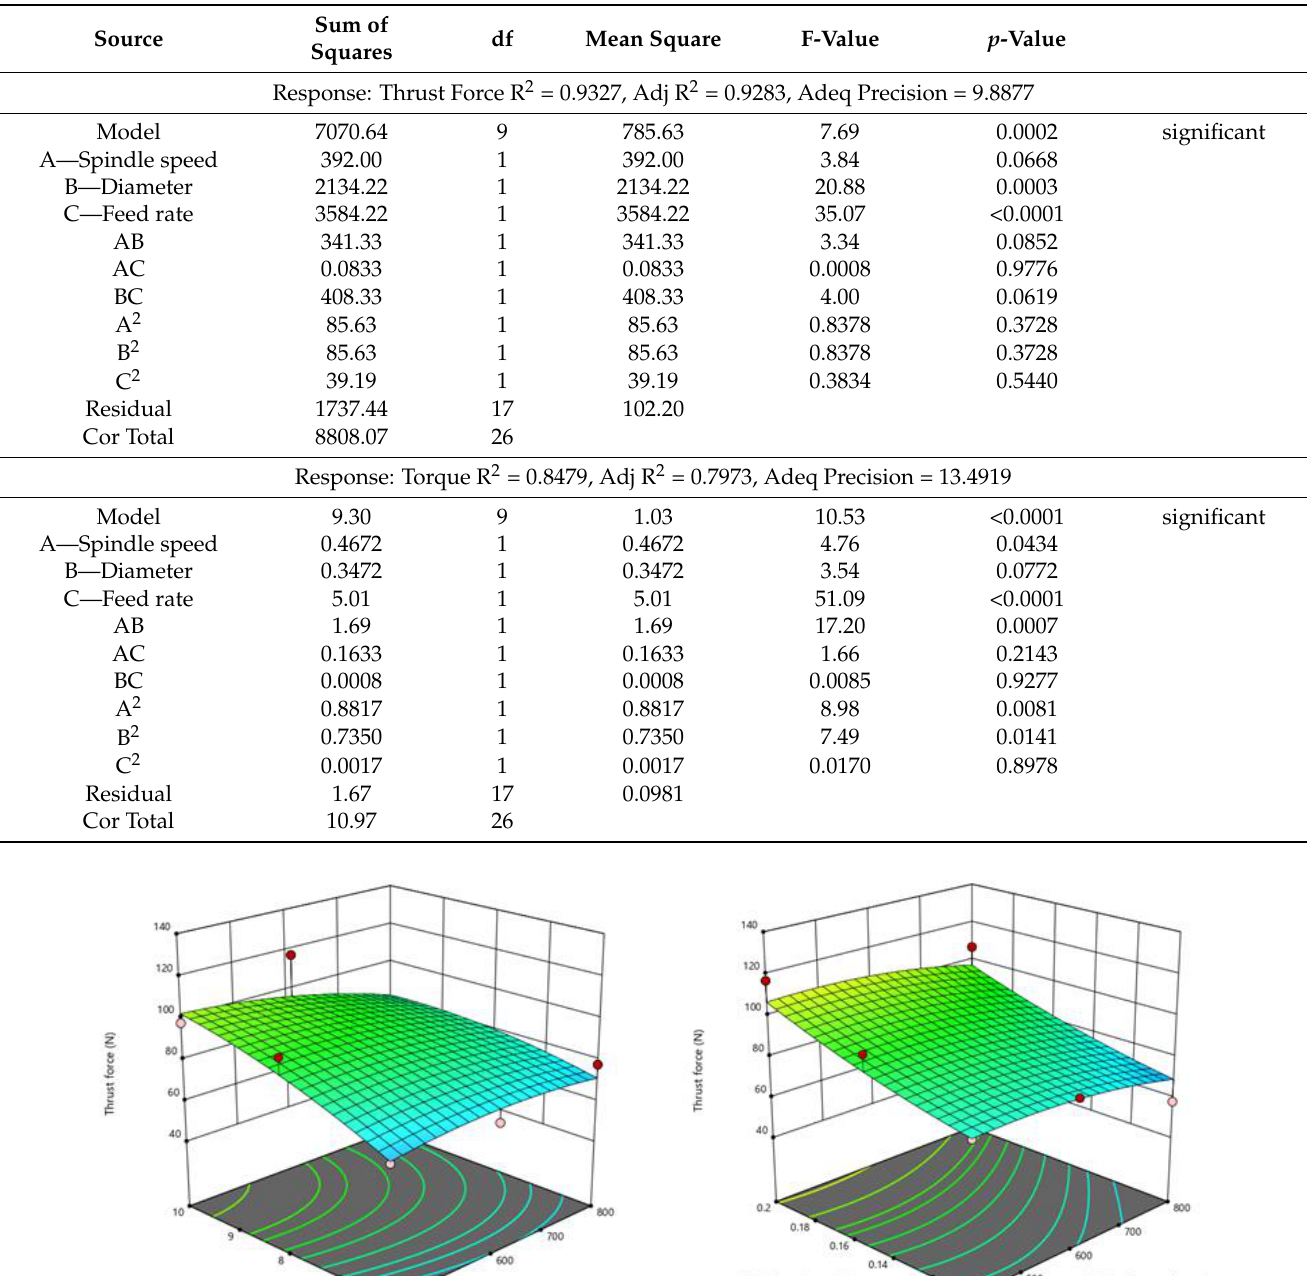
Table 4. ANOVA generated for the response “Thrust Force” and “Torque”.